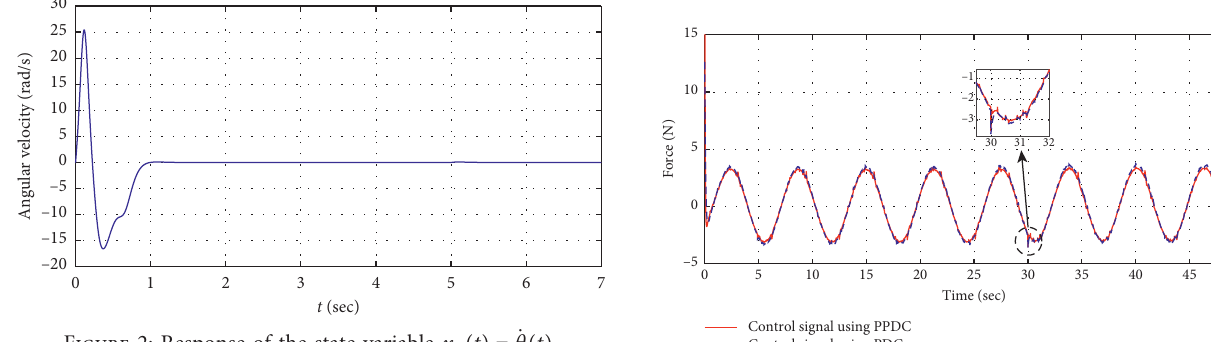
( t ) � _ θ ( t ) . 2 Figure 6: Control signals using PDC and PPDC